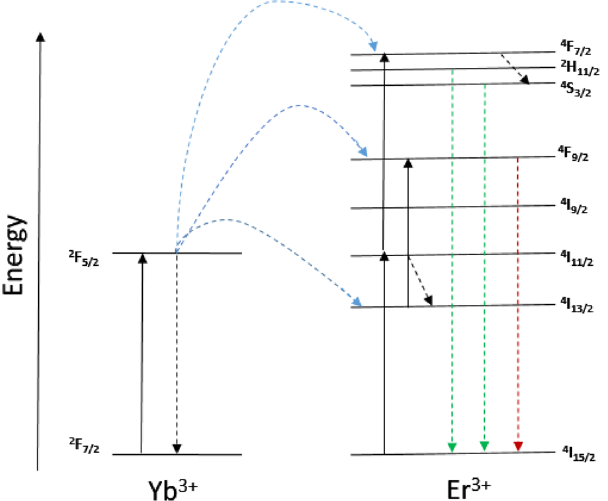
Figure 4. Energy level diagram and upconversion mechanism for the Yb 3 + and Er 3 + co- doped UCNPs system upon 980 nm laser excitation. Three major emission peaks centered at 520 nm, 540 nm, and 656 nm are observed in the range of UV to visible light spectrum, where two green emissions at 520 nm and540 nm are assigned to the 2 H 11 / 24 I 15 / 2 and 4 S 3 / 24 I 15 / 2 transition, respectively; and the red emission at 656 nm is assigned to the 4 F 9 / 24 I 15 / 2 transition. The UCPL of Er 3 + and Yb 3 + ions co-doped nanoparticles excited by a 980 nm laser emit yellowish green light, which is a combination of green and red colour